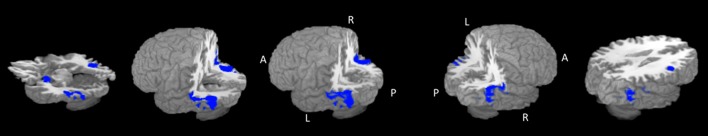
Rendered ALE map showing significant concordance across studies for dynamic facial expressions. A, anterior; P, Posterior; L, left; R, right. All coordinates are listed in Table 2.